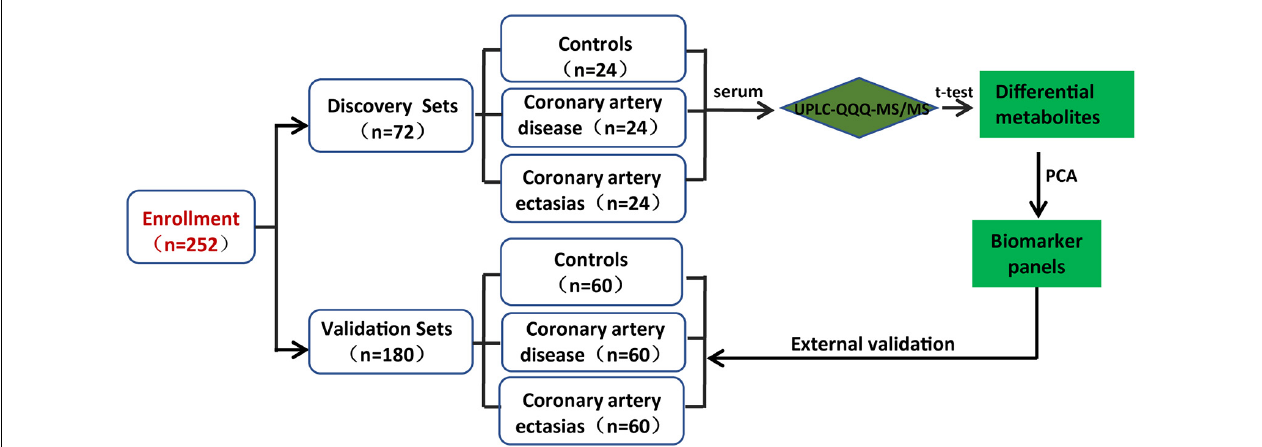
FIGURE 1 | Design of the